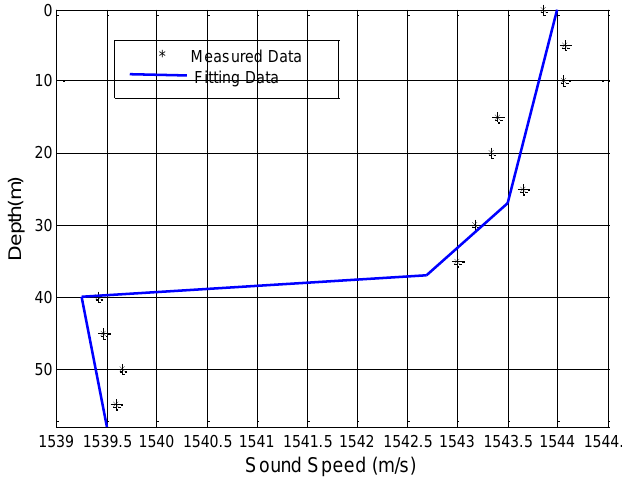
Figure 8. Sound speed variations with depths in an Australian ocean site.